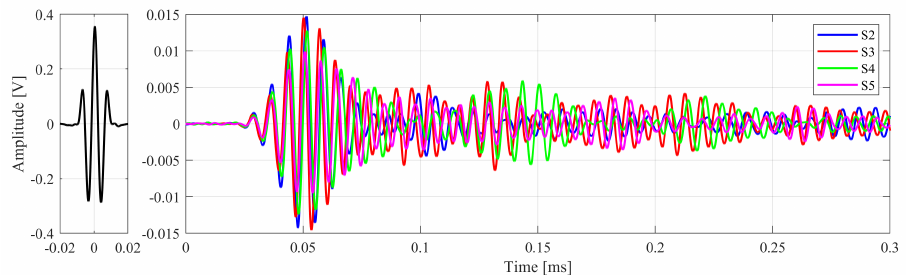
Figure 6. Excitation signal and the received responses measured at the S2 to S5 bolts in the P1